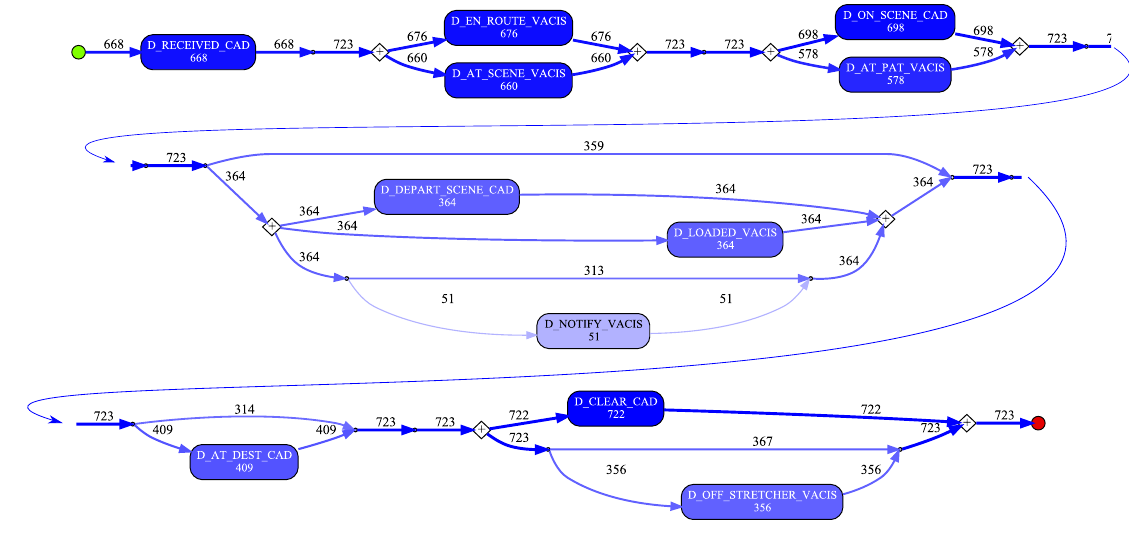
Figure 9. QAS process model derived from sample data.